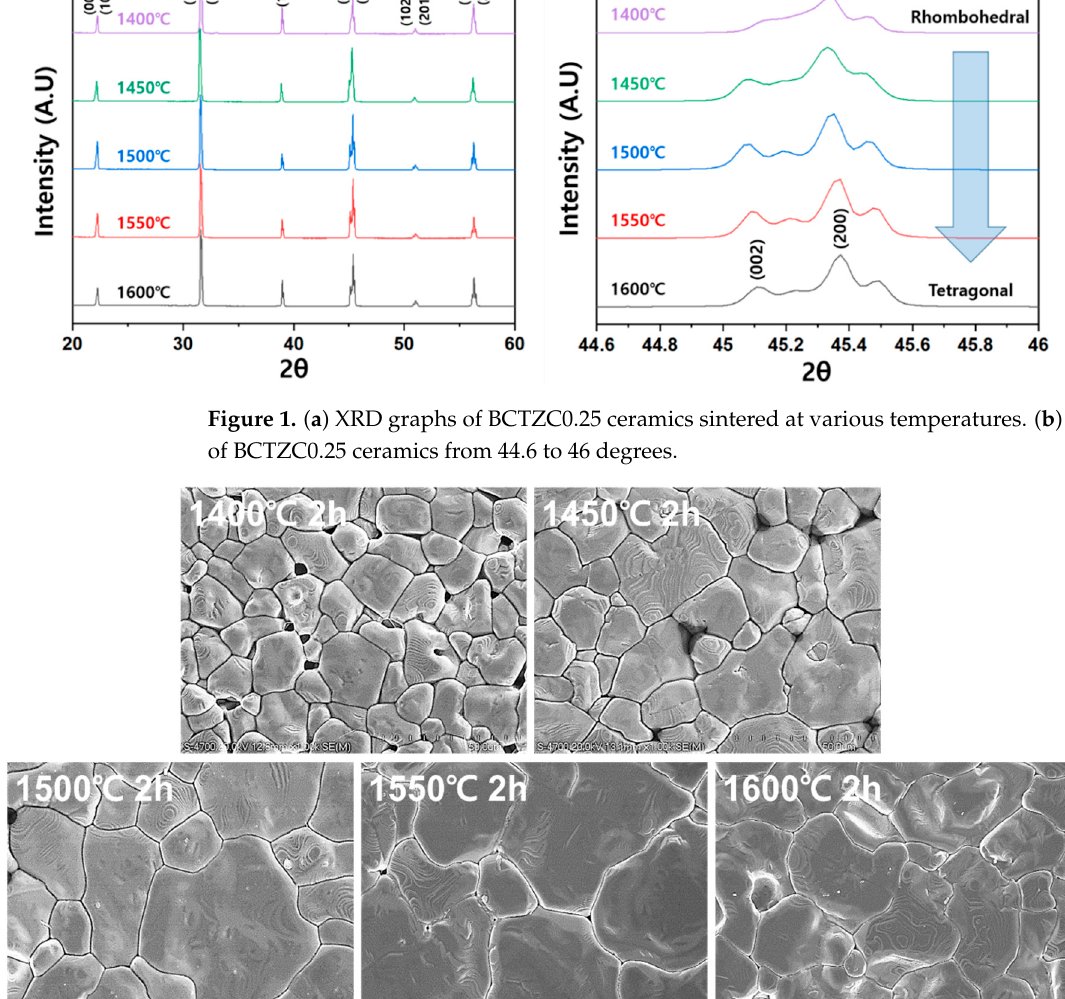
Figure 1. ( a ) XRD graphs of BCTZC0.25 ceramics sintered at various temperatures. ( b ) XRD graphs of BCTZC0.25 ceramics from 44.6 to 46 degrees.